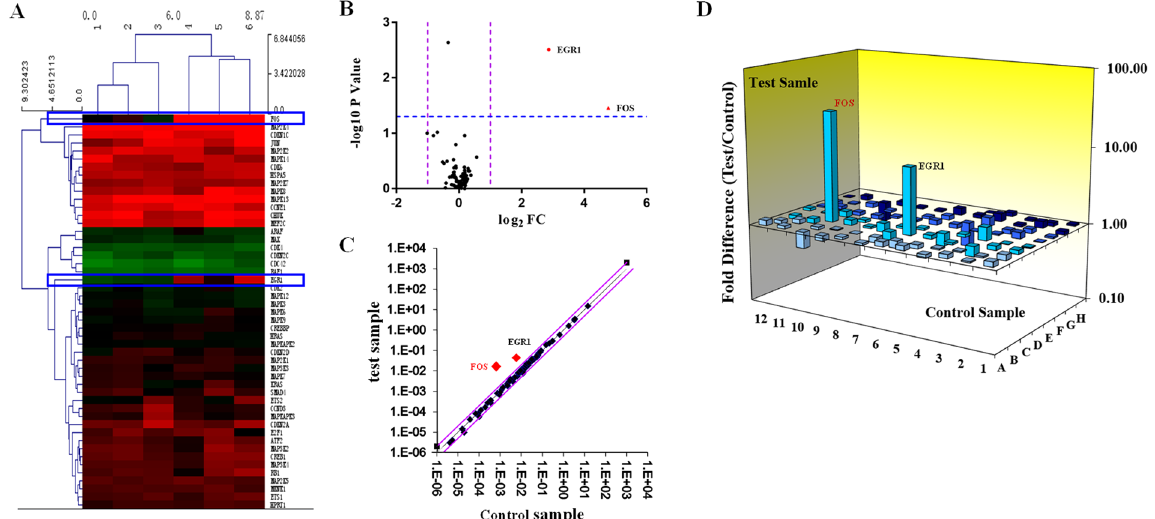
Figure 4. Screening FOS as the target gene with MAPK-PCR chip. After intervention with 0.1 mg/L BER 15 mins, the results of MAPK-PCR chip are as follows: ( A ) Clustering map, ( B ) volcano plot, ( C ) scatter